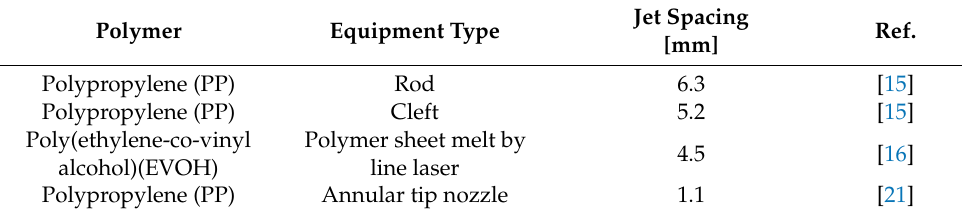
Table 1. List of jet spacing of polymer needleless melt